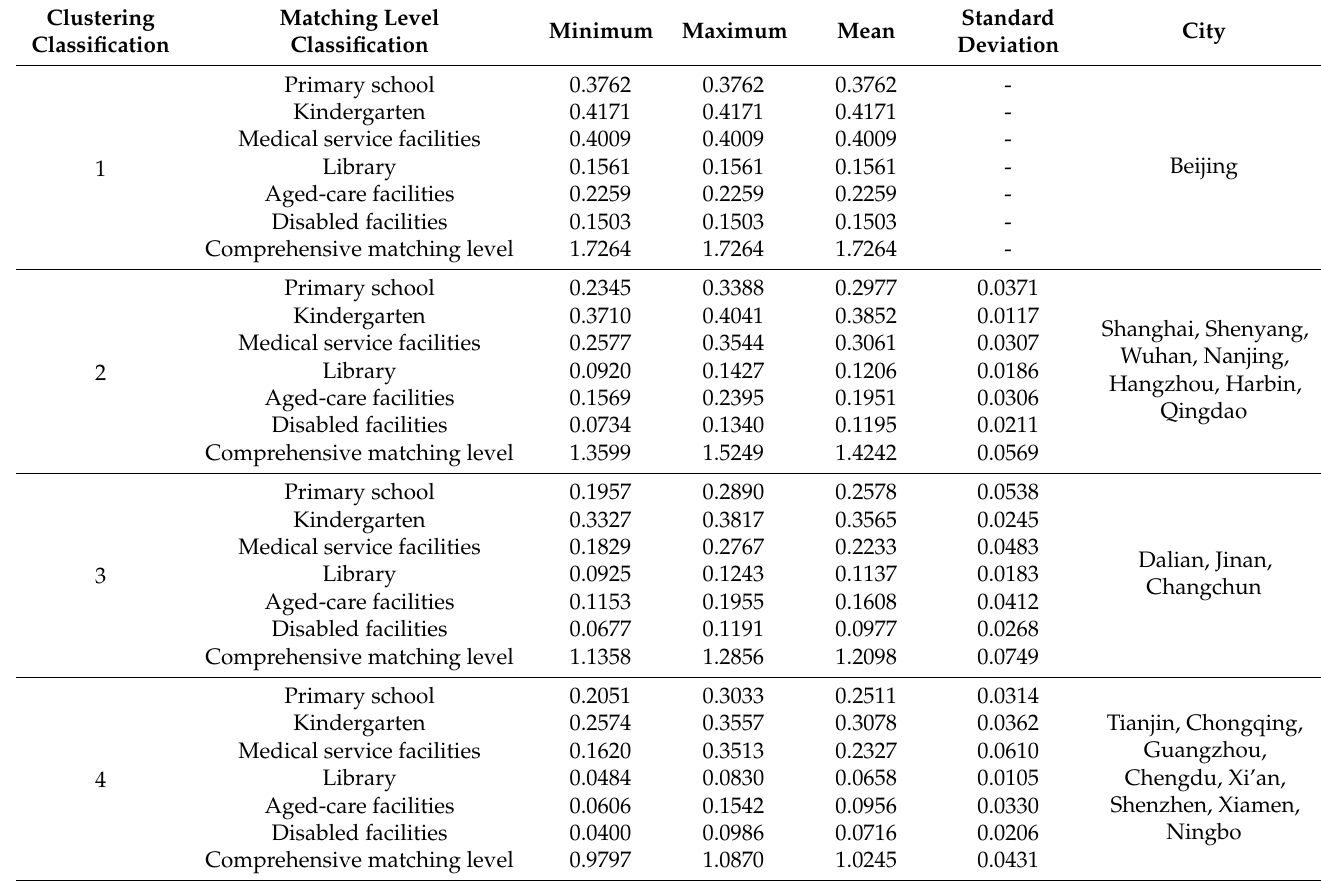
Table 5. Comprehensive cluster classification results of basic